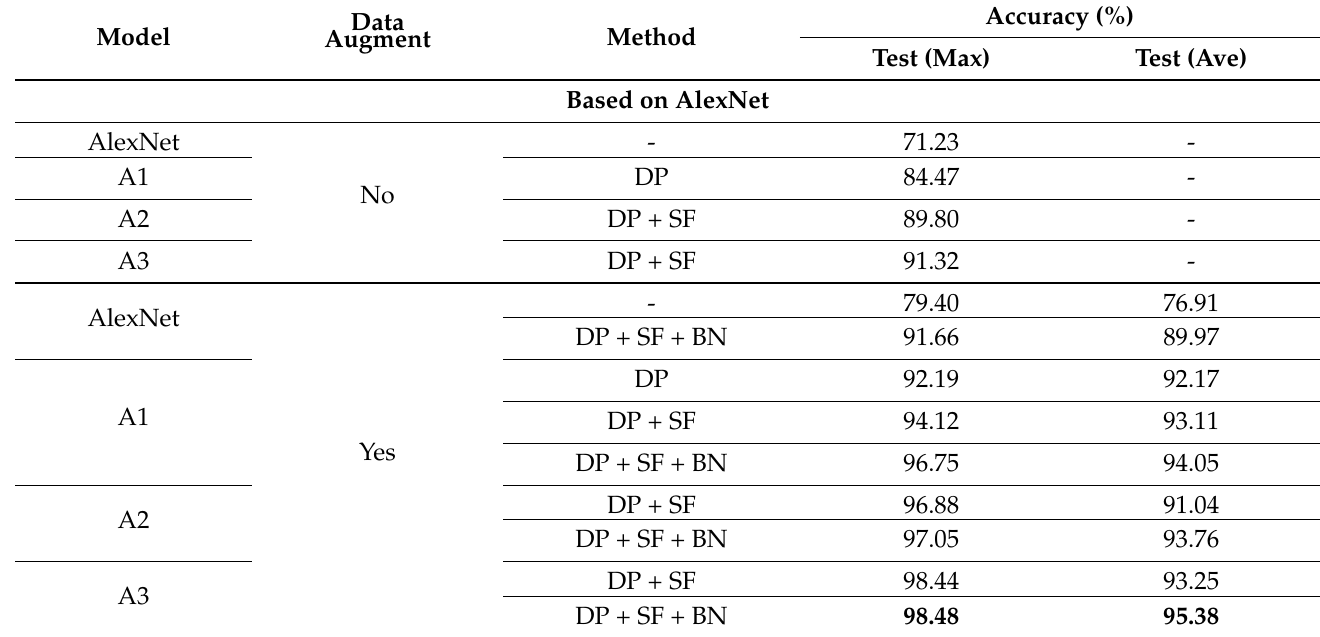
Table 3. Recognition accuracy of AlexNet-based models on unaugmented (No) and augmented (Yes) OBI datasets. BN, DP, SF represent batch normalization, dropout, and shuffle methods, respectively. Test (max) denotes the maximum recognition accuracy rate and Test (ave) represents the average value of the last five accuracy rates after the training is stable. Bold numbers indicate the optimal value of each indicator in each group of network